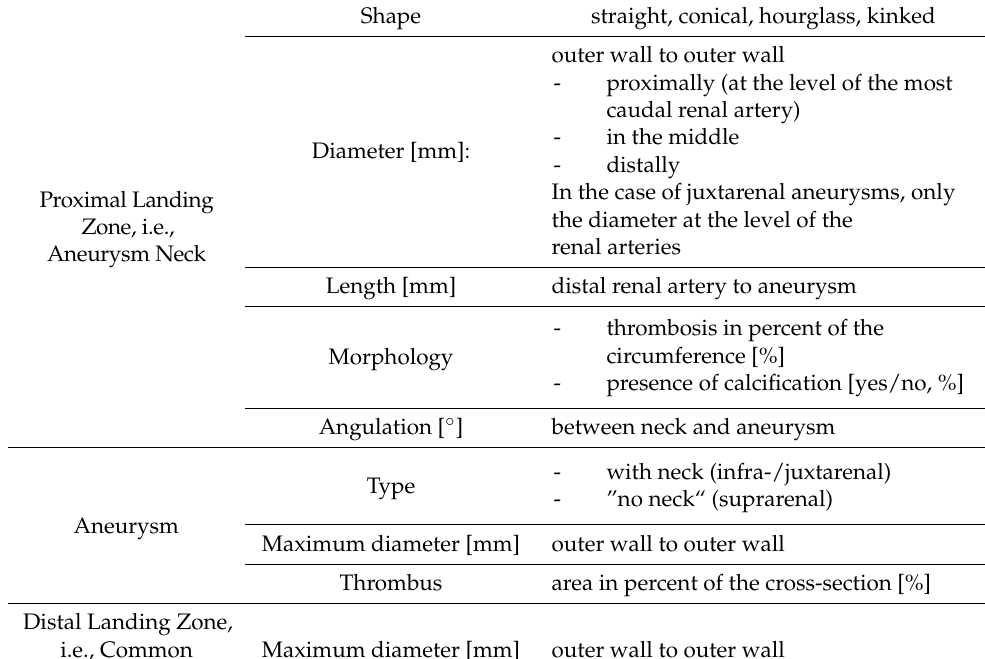
Table 1. Parameters obtained from the three-dimensional imaging data. Shape straight, conical, hourglass, kinked outer wall to outer wall - proximally (at the level of the most caudal renal artery) - in the middle Diameter [mm]: - distally In the case of juxtarenal aneurysms, only Proximal Landing the diameter at the level of the Zone, i.e., renal arteries Aneurysm Neck Length [mm] distal renal artery to aneurysm - thrombosis in percent of the circumference [%] Morphology - presence of calcification [yes/no, %] Angulation [ ◦ ] between neck and aneurysm - with neck (infra-/juxtarenal) Type - ”no neck“ (suprarenal) Aneurysm Maximum diameter [mm] Thrombus area in percent of the cross-section [%] Distal Landing